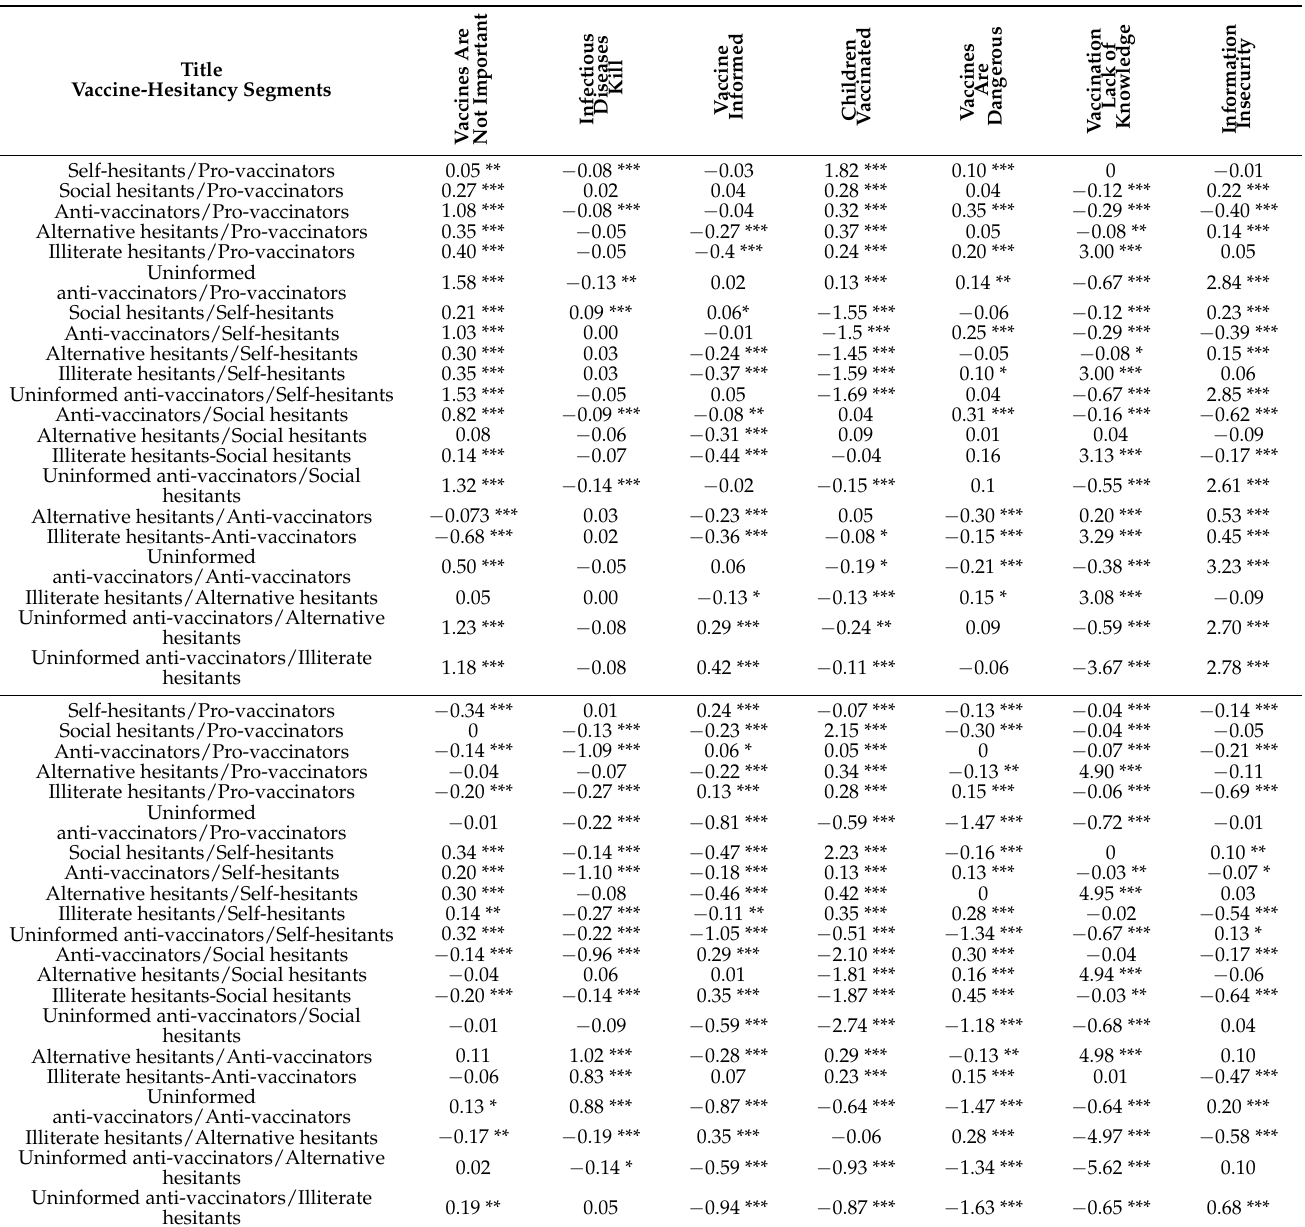
Table A3. ANOVA (Tukey HSD). Segments’ mean